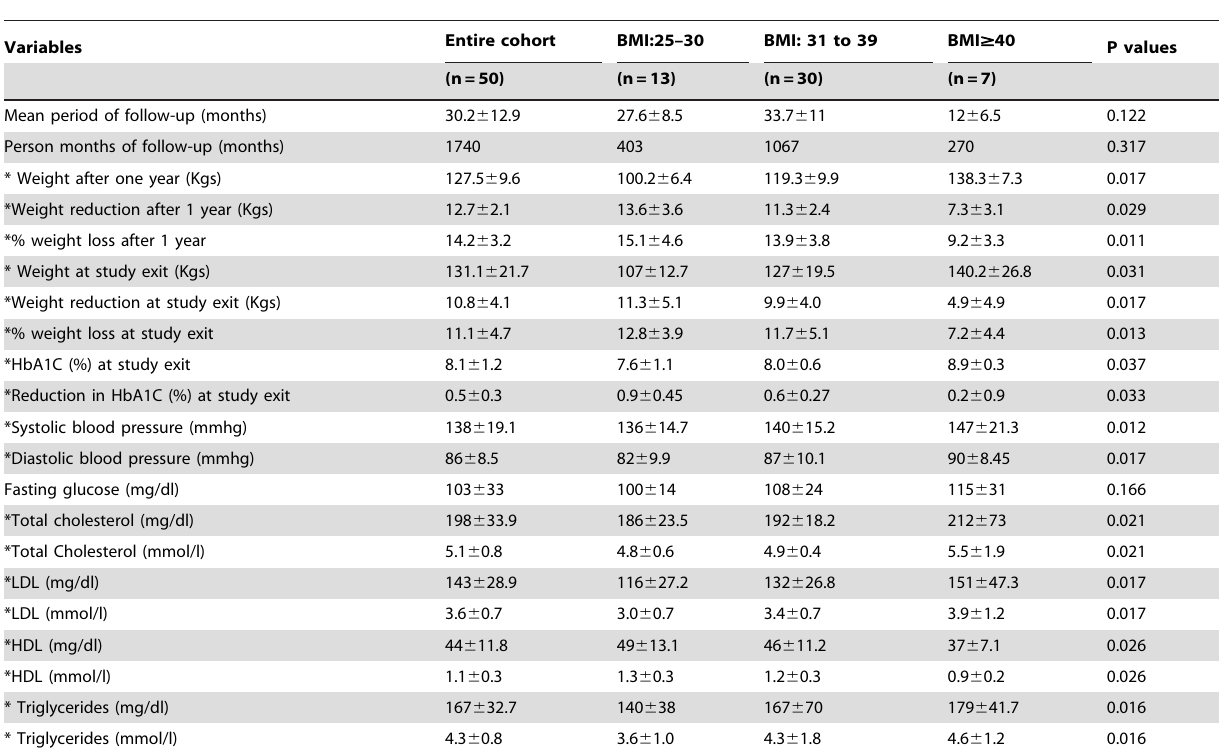
Table 3. Participant characteristics at study